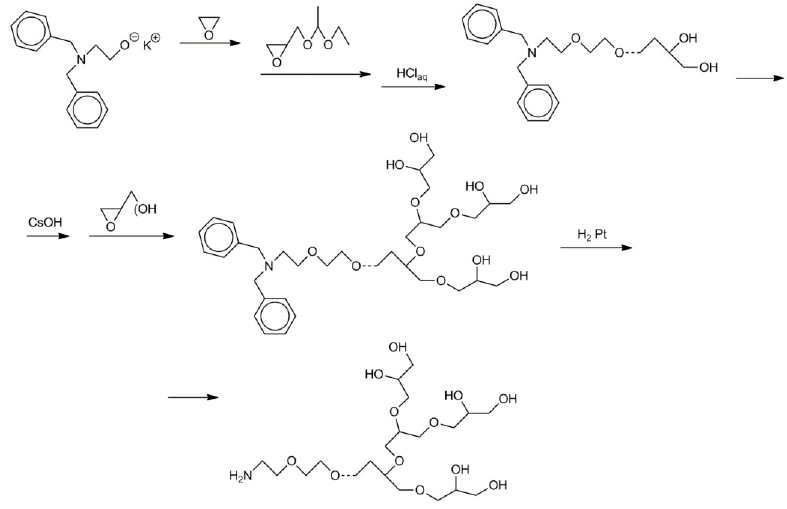
Scheme 22. Synthesis of branched polyglycidol with primary amine groups.